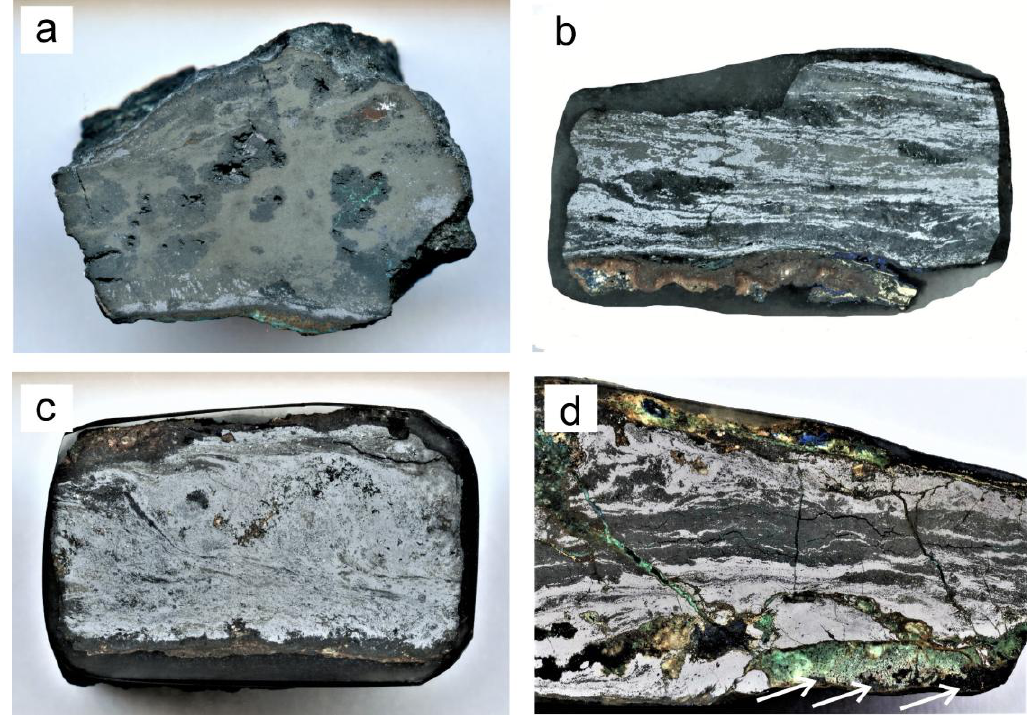
Figure 5. ( a ) Dispersed-light dark field image of Se-veinlet Type-1 (1.7-cm-thick, 2.3-cm-wide, surface rolling grinded, with 1200 mesh SiC abrasive) with eucairite (olive brown) as the main selenide interspersed with irregularly shaped pores inside patchy aggregates of naumannite and klockmannite (dark grey). Clausthalite (light grey) occurs prevalently in thin layers at the vein wall. Notably, the ductile deformation with lineation of the selenides is limited to the vein selvage; ( b ) Dispersed light dark field image of Se-veinlet Type-2 (1-cm-thick, 2.1-cm-wide, embedded in resin, surface rolling grinded, with 1200 mesh SiC abrasive) with eucairite (olive brown) showing a strongly foliated and folded m é lange of naumannite and klockmannite (dark grey), clausthalite (light grey) and eucairite (olive brown). The vein selvage contains remnants of chalcopyrite (bright yellow) and as alteration products goethite (dark brown) and malachite (green); ( c ) Dispersed-light dark field image of Se-veinlet Type-3 (1.5-cm-thick, 2.5-cm-wide, embedded in resin, surface rolling grinded, with 1200 mesh SiC abrasive) with a strongly foliated and folded m é lange of eskebornite (light brown), klockmannite (dark grey), clausthalite (light grey), and naumannite. The vein selvage contains goethite as the main alteration product (brown). Also shown are partly rotated spotty aggregates of trachytic host-rock fragments; ( d ) Dispersed-light dark field image of Se-veinlet Type-4 (detail from Figure 1, 2.2-cm-thick, 4-cm-wide, embedded in resin, surface rolling grinded, with 1200 mesh SiC abrasive) with layers and lenses of klockmannite (dark grey) and clausthalite (light grey) showing a strongly foliated and folded m é lange. Vein selvage, host-rock fragments, and diagonal fractures are stained by goethite (dark brown), azurite and chalcomenite (blue), and malachite (green). Bitumen rarely occurs as irregularly distributed cement impregnating host-rock fragments from the vein wall inwards (see white